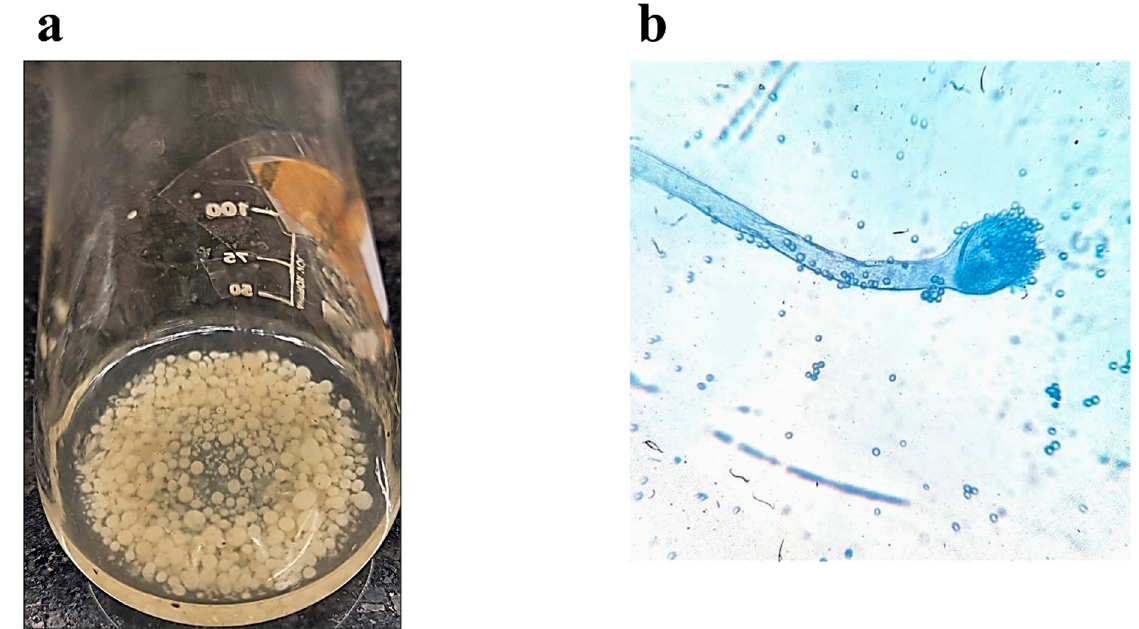
Figure 2. Pictures representing ( a ) Aspergillus flavus BU22S pellets formed in the biotransformation media, ( b ) Aspergillus flavus BU22S spores stained with Methylene Blue.